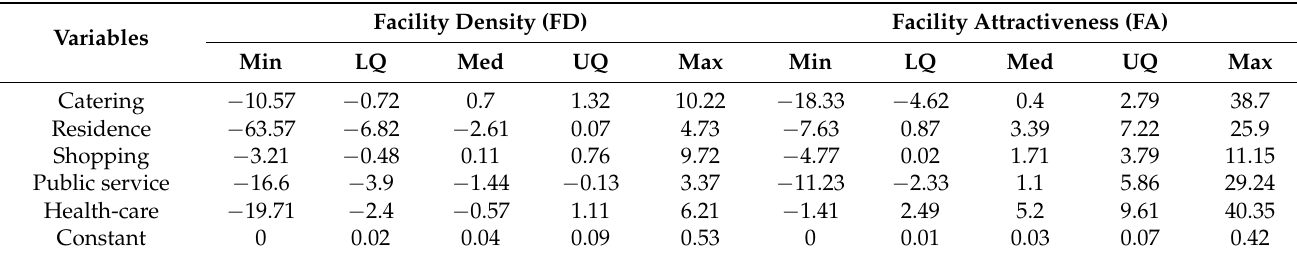
Table 4. Estimation summaries for the GTWR coefficients of the FD and FA models.